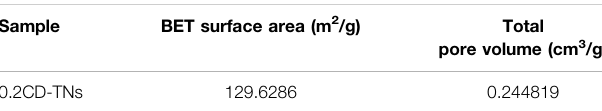
TABLE 2 | Textural properties of 0.2CD-TNs.